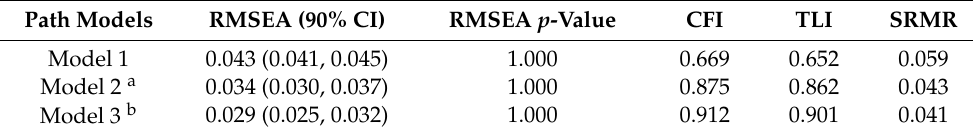
Table 1. Goodness of fit indices of the tested measurement models. Path Models